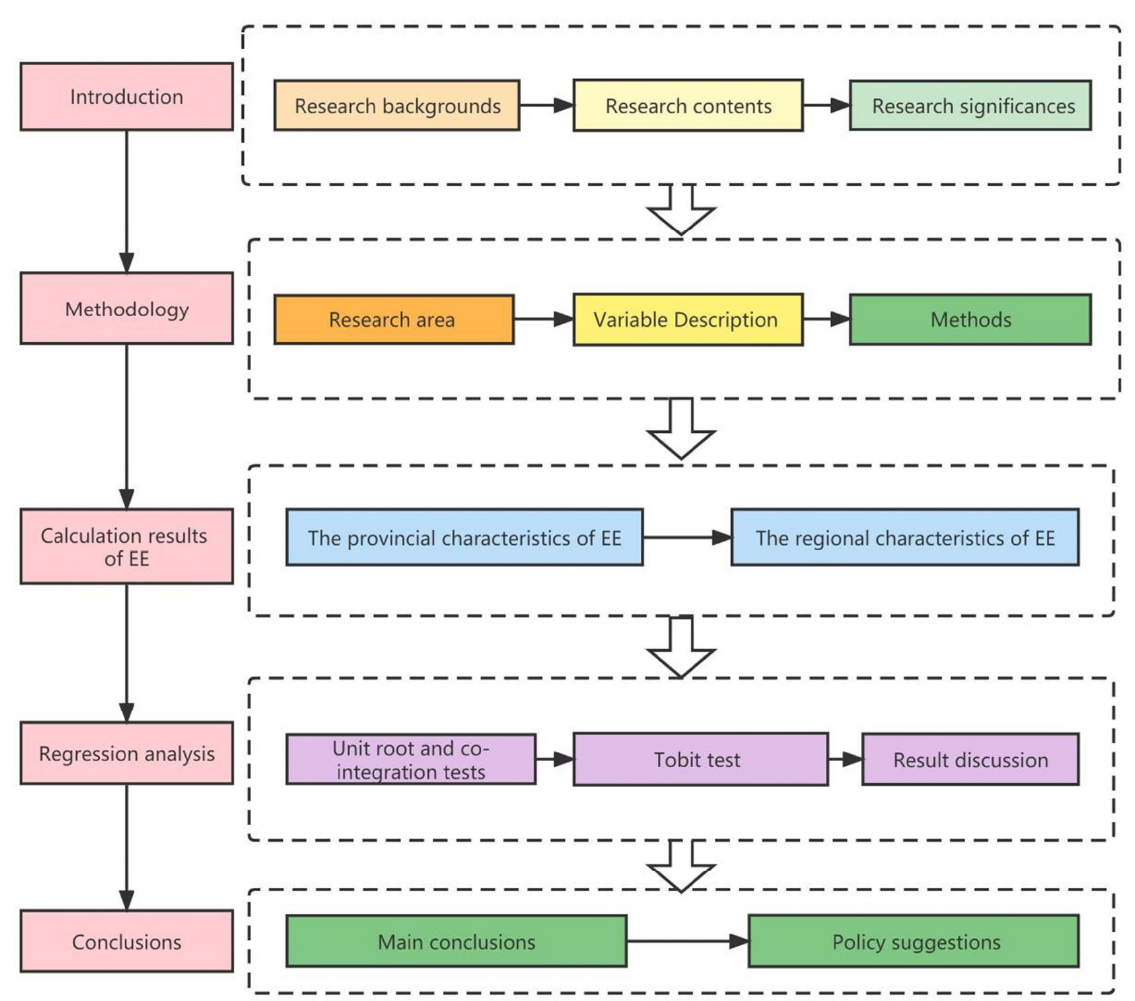
Figure 1. The flowchart of the empirical research.